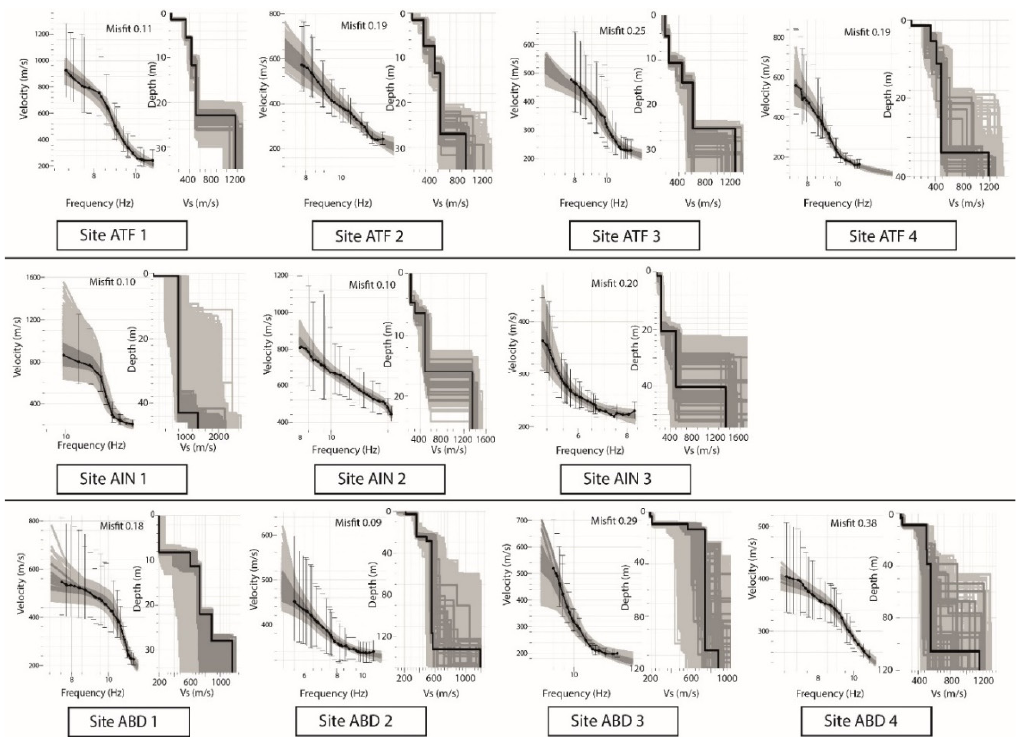
Figure 5. Results of the inversion of Rayleigh waves dispersion curves. The left panels for each site represent the dispersion curves. The right panels represent the Vs models. The black line corresponds to the best fit model, the dark grey represents models with minimum misfit + 10%. All the tested models are in light grey. The misfit is shown at the middle top of each site.